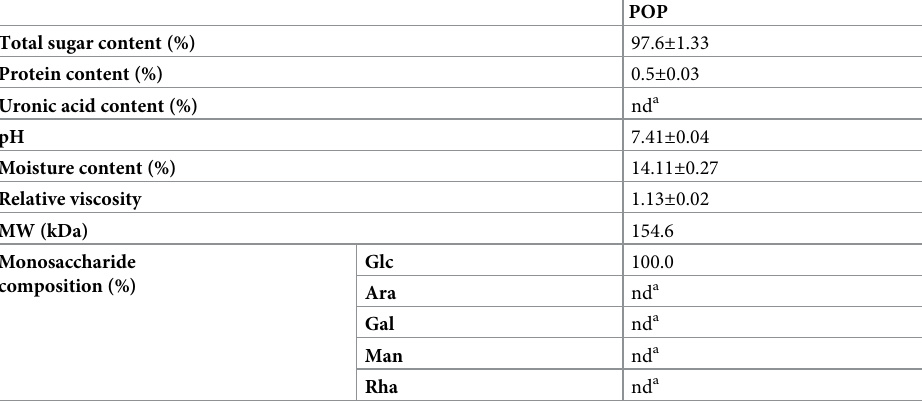
Table 3. Chemical and sugar composition of POP.